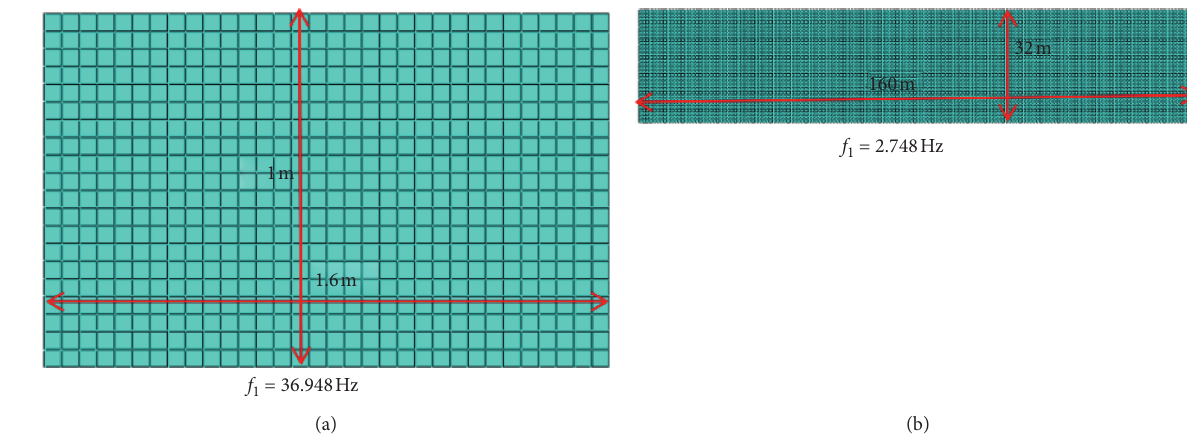
Figure 5: Numerical model and frequency. (a) Model. (b) Prototype.